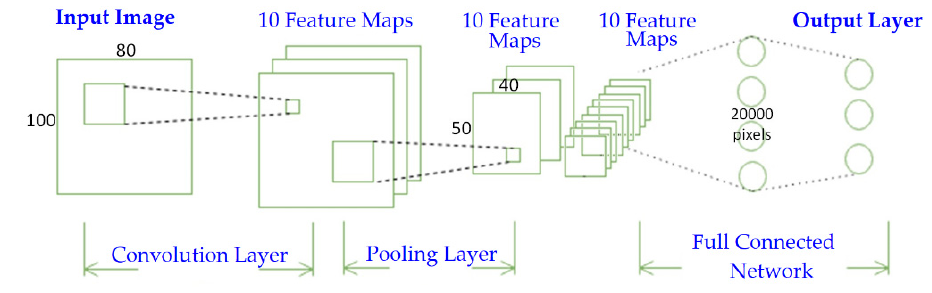
Figure 13. The structure of CNN.